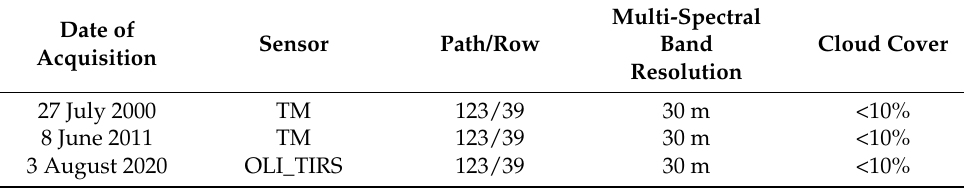
Table 1. Description of the collected seasonal satellite image from USGS Earth